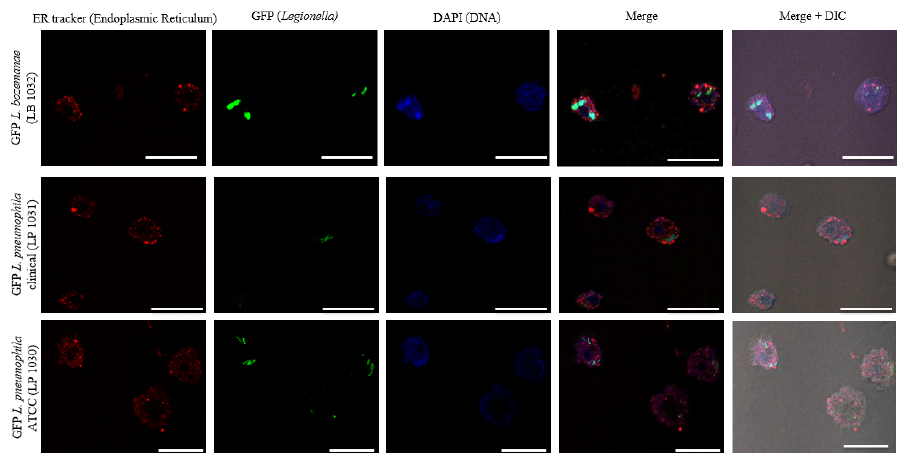
Figure 4. Confocal micrographs of A. castellanii infected with GFP-expressing Legionella strains. Image panels represent A. castellanii protozoa infected with GFP-expressing L. bozemanae, L. pneumophila , and L. pneumophila ATCC 33,152 strains 12 h post-infection visualized with a Zeiss LSM 700 confocal microscope. Individual fl uorescence channels are displayed. The panel on the far right represents the merged fl uorescence channels (green, GFP bacteria; red, endoplasmic reticulum; blue, DNA; and DIC). Scale bar = 10 μ M. ATCC, American Type Culture Collection; DIC, Differential interference contrast; GFP, Green fluorescent protein.